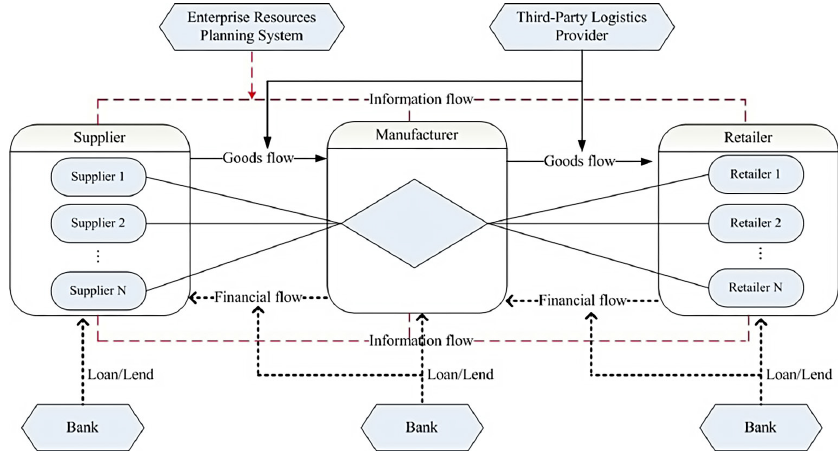
Fig. 1. The three flows of a traditional SCM system